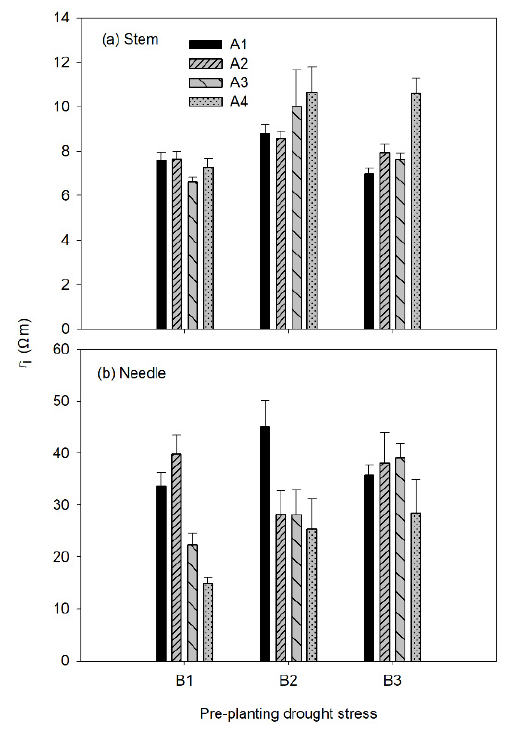
Figure 3. Intracellular resistance ( r i ) of stems ( a ) and needles ( b ) in lacebark pine seedlings by four weeks of post-planting drought treatments (A1, A2, A3, and A4). A1, 75%–80% soil relative water content (SRWC); A2, 55%–60% SRWC; A3, 35%–40% SRWC; and A4, 15%–20% SRWC. B1, adequate irrigation before planting; B2, 5 days of drought before planting; and B3, 10 days of drought before